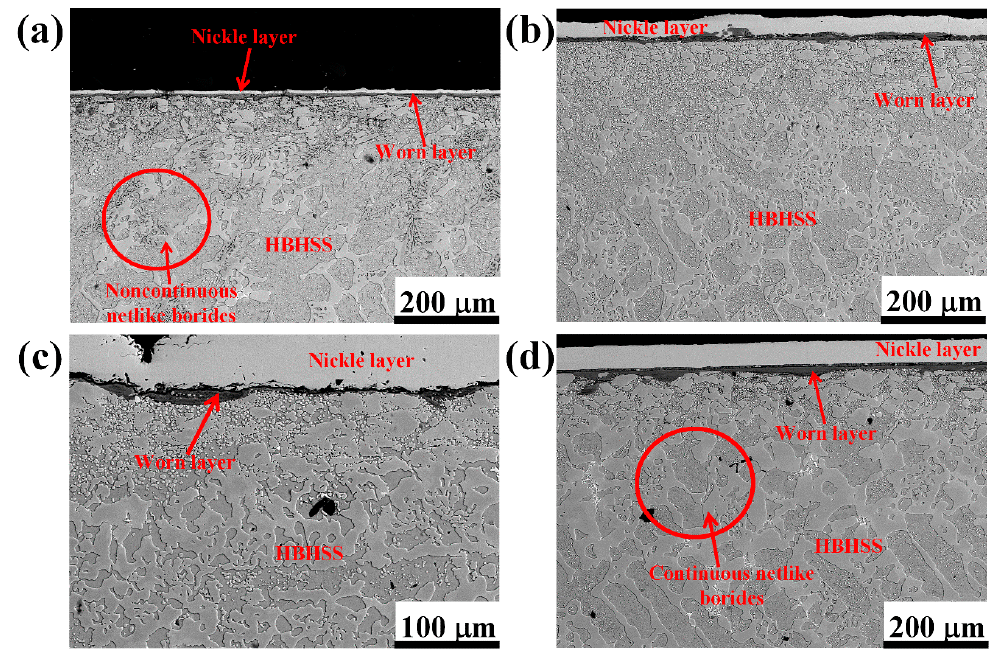
Figure 8. Cross-section morphologies of HBHSSs after oxidation wear at 800 °C for 100 N: ( a ) A1, ( b ) A2, ( c ) A3, ( d )